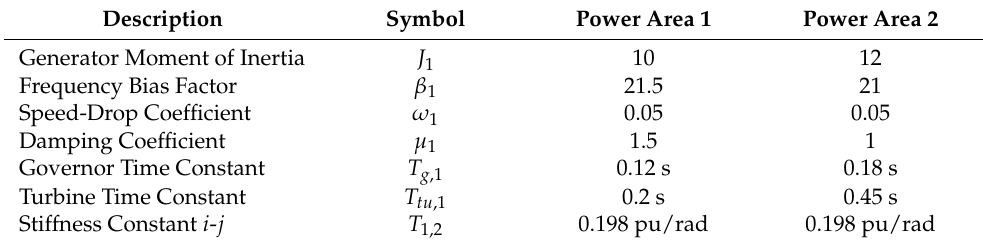
Figure 3. Two-agent load frequency control (LFC) system. Table 2. Simulated Power Areas’ Parameter